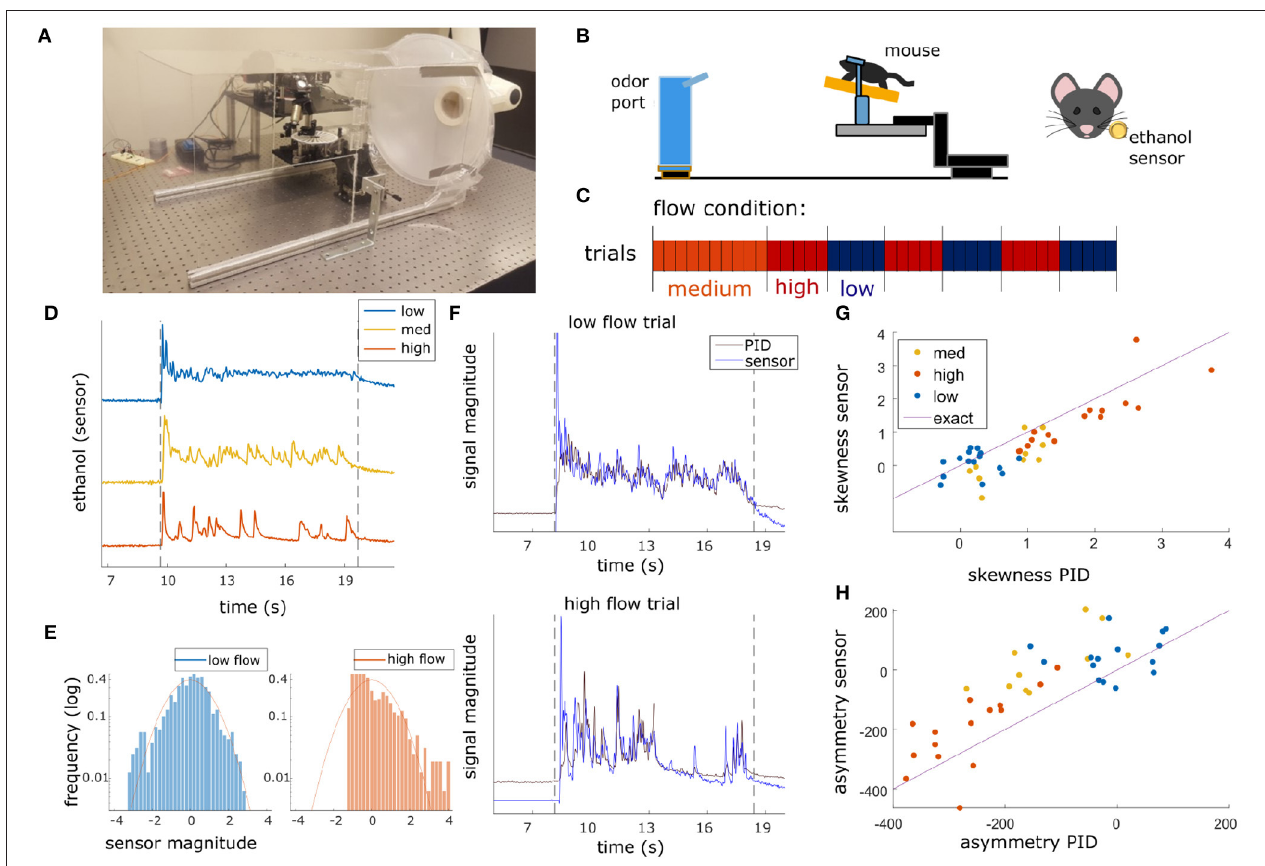
FIGURE 1 | Plume presentations and head-fix setup for in-vivo recording experiments. (A) All experiments conducted in a 40 × 40 × 80 cm wind tunnel for quick clearing of odor presentations. The odor port (not pictured) was located ∼ 13 cms upwind of the animal’s nose. (B) (Left) Graphic detailing experimental setup. (Right) Ethanol odor concentration measured using a modified, commercially available ethanol sensor placed ∼ 4 mm from the outer edge of the mouse’s nostril. (C) Diagram depicting flow conditions (high, medium, or low) of the 40 trials within a single session. (D) Example odor traces are depicted for each flow condition. (E) Histograms of the odor concentration magnitude sampled across two examples trials show a change in skewness between low flow (left, blue) and high flow (right, red), with skewness increasing with increased airflow during plume presentations. (F) Comparisons between the deconvolved sensor signal and a PID signal during a set of paired recordings show odor concentration dynamics of the deconvolution can recover dynamics observed in the PID recordings ( r = 0.61, p < 0.001). An example from low flow (top) and high flow (bottom) are shown. (G,H) Skewness (G) and asymmetry (H) of the deconvolved ethanol signal vs. the PID traces for each trial. All points lie close to the bisector (Purple line, labeled “exact”) showing that the deconvolution preserves measures of skewness and asymmetry consistent to the PID trace. High flow trials (orange) are separable from low flow trials (blue) and are substantially different from 0 (the expectation for any symmetric distribution, e.g., a